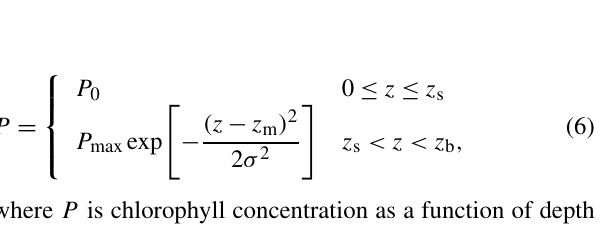
Figure 2. Examples of the vertical profiles of chlorophyll (black solid line). (Red dash–dotted lines represent the parts of Gaussian fitting curves, not the actual